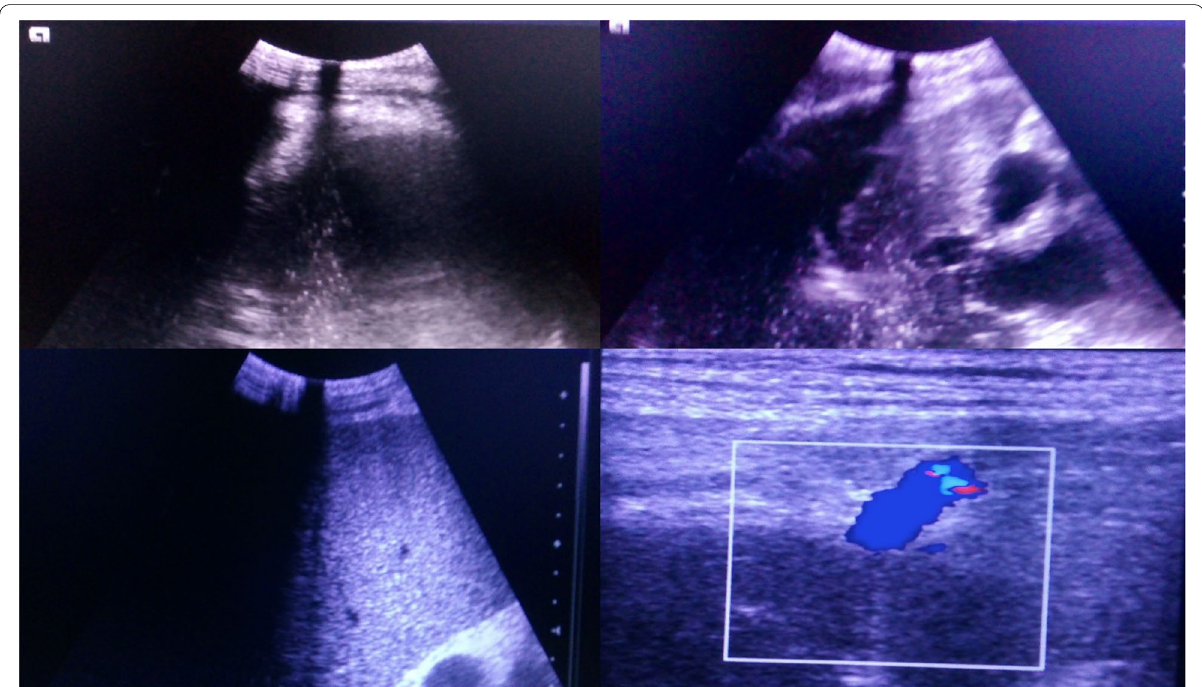
Fig. 1 Abdominal ultrasound showing a large, rounded, well-limited cystic mass in communication with the common bile